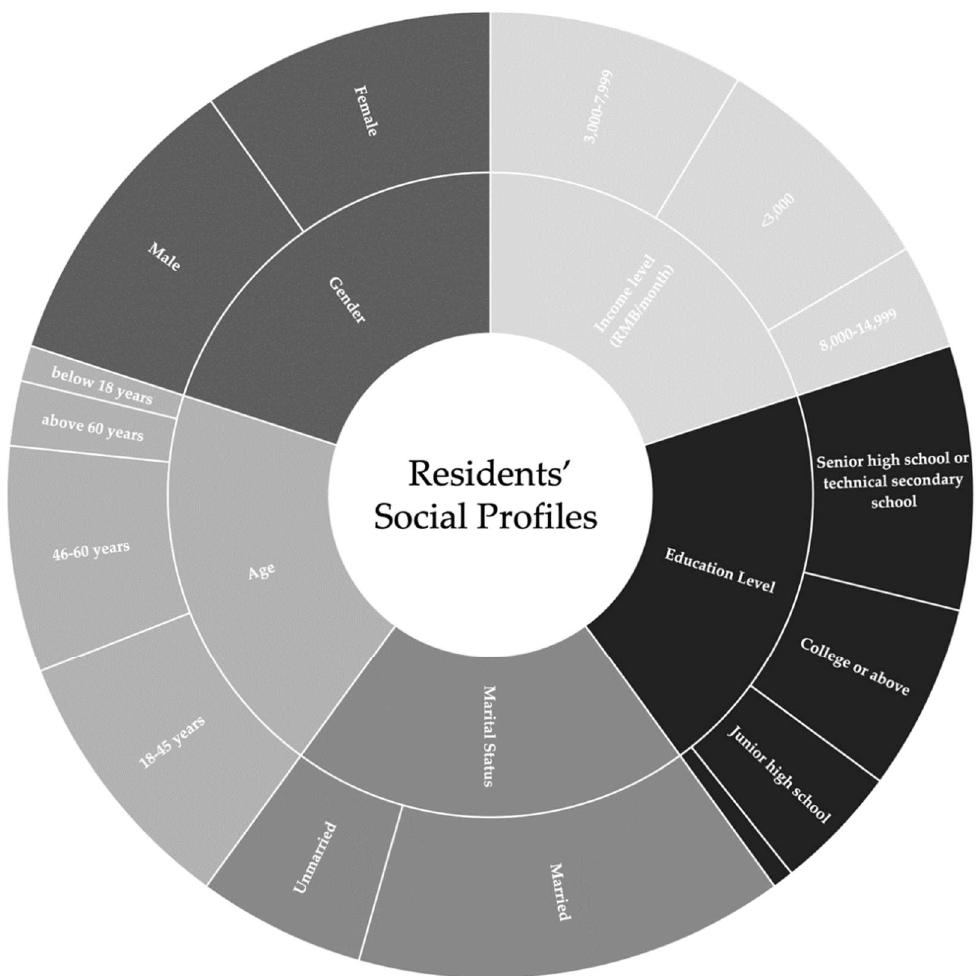
Figure 4. The sample attributes (Source: Compiled by the researcher).